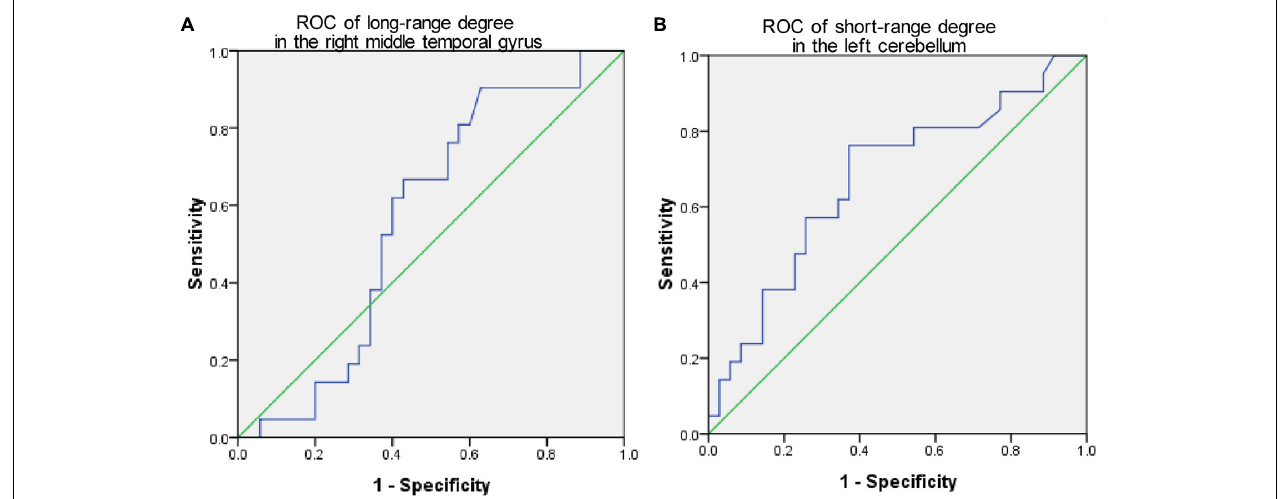
FIGURE 4 | The Receiver-operator characteristic-curves (ROCs) based on the degree value of brain regions with significant cross-sectional difference between PMCI and stable MCI (SMCI) groups at baseline. (A) The ROC of the long-range degree in the right middle temporal gyrus; (B) The ROC of the short-range degree in the left